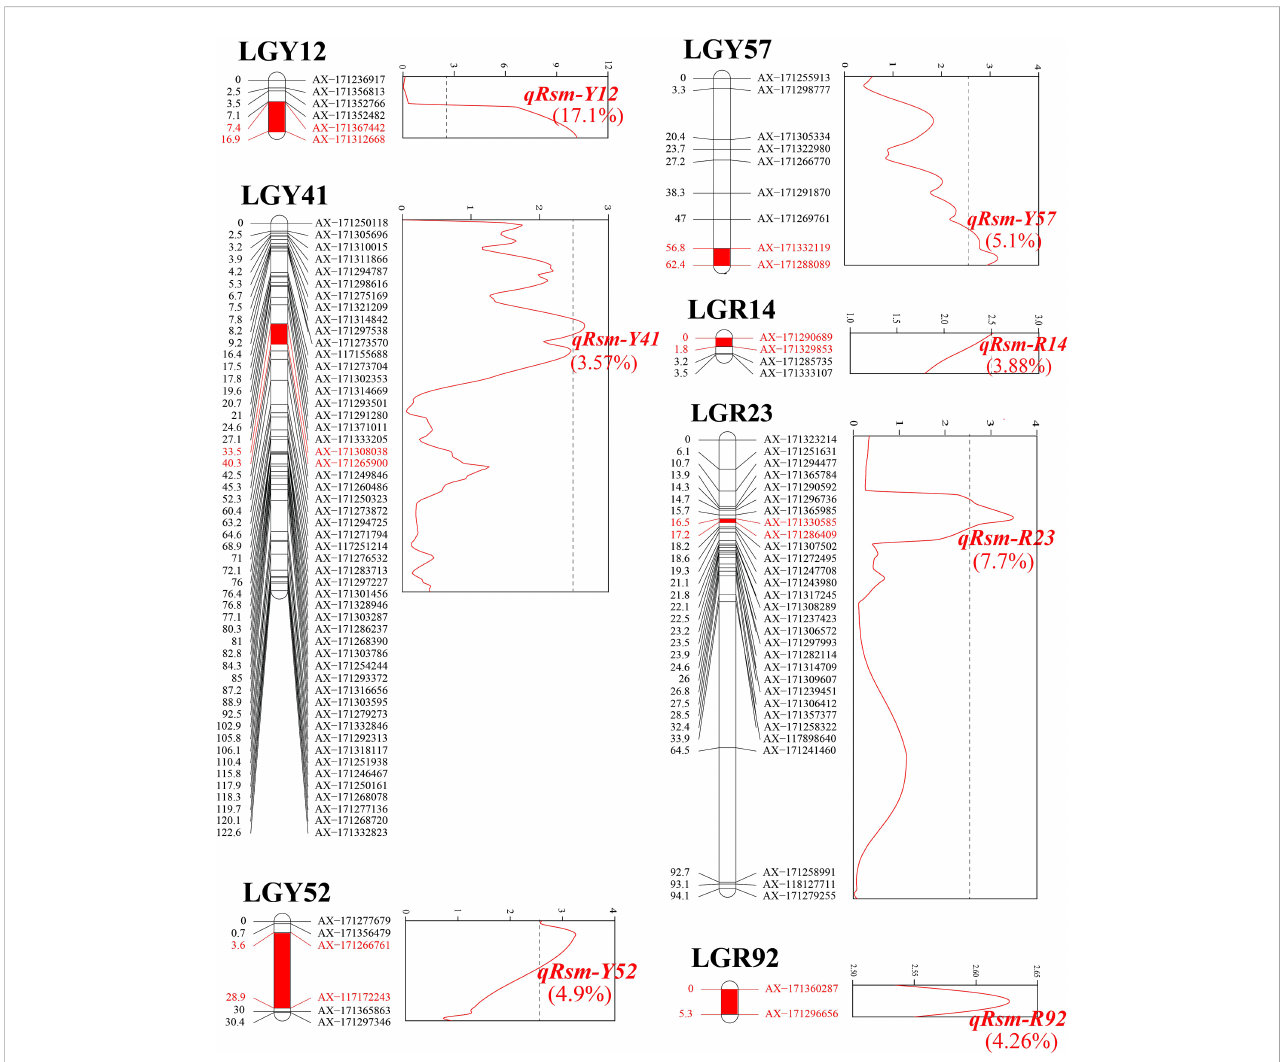
FIGURE 4 Location of seven SMD resistance-related QTLs ( q ) on sugarcane genetic linkage maps “ Rsm ” , resistance trait to sugarcane mosaic disease; “ Y ” , YT93- 159; and “ R ” , ROC22. The colored text values, phenotypic variation explained